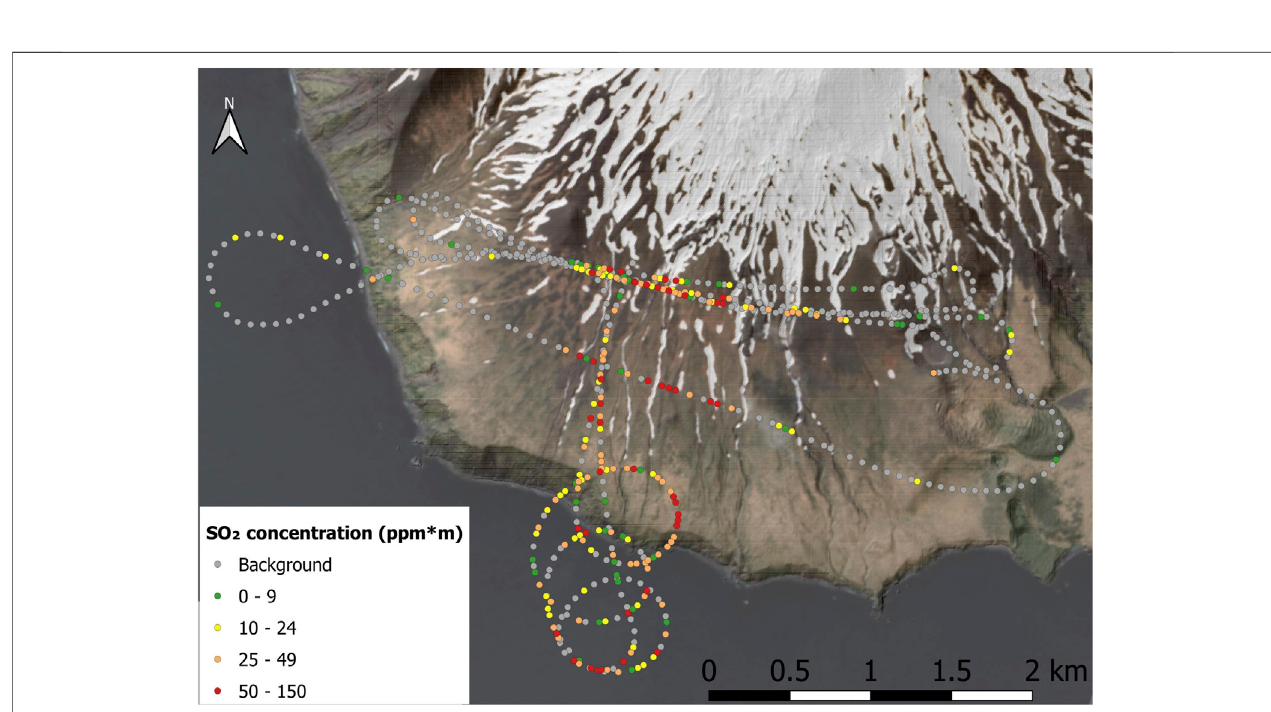
FIGURE 5 | Example of a fl ight path performed at Gareloi volcano for helicopter-based SO 2 concentration measurements in the plume. The Sentenial image used here was provided by Chris Waythomas, USGS.